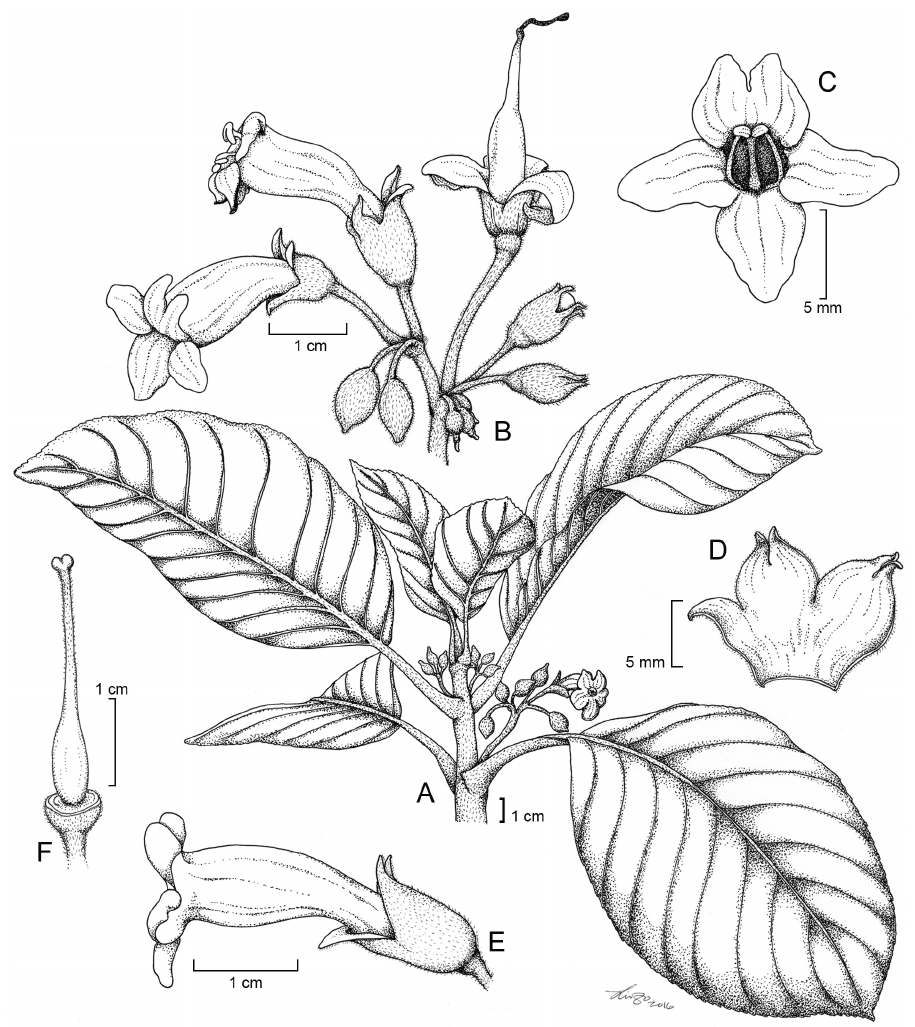
Figure 1. Cyrtandra gregoryi M.A.Johnson A Habit B Inflorescence C Corolla, anterior view D Calyx E Flower, lateral view F Gynoecium. Drawn from Johnson 105 (RSA) and field